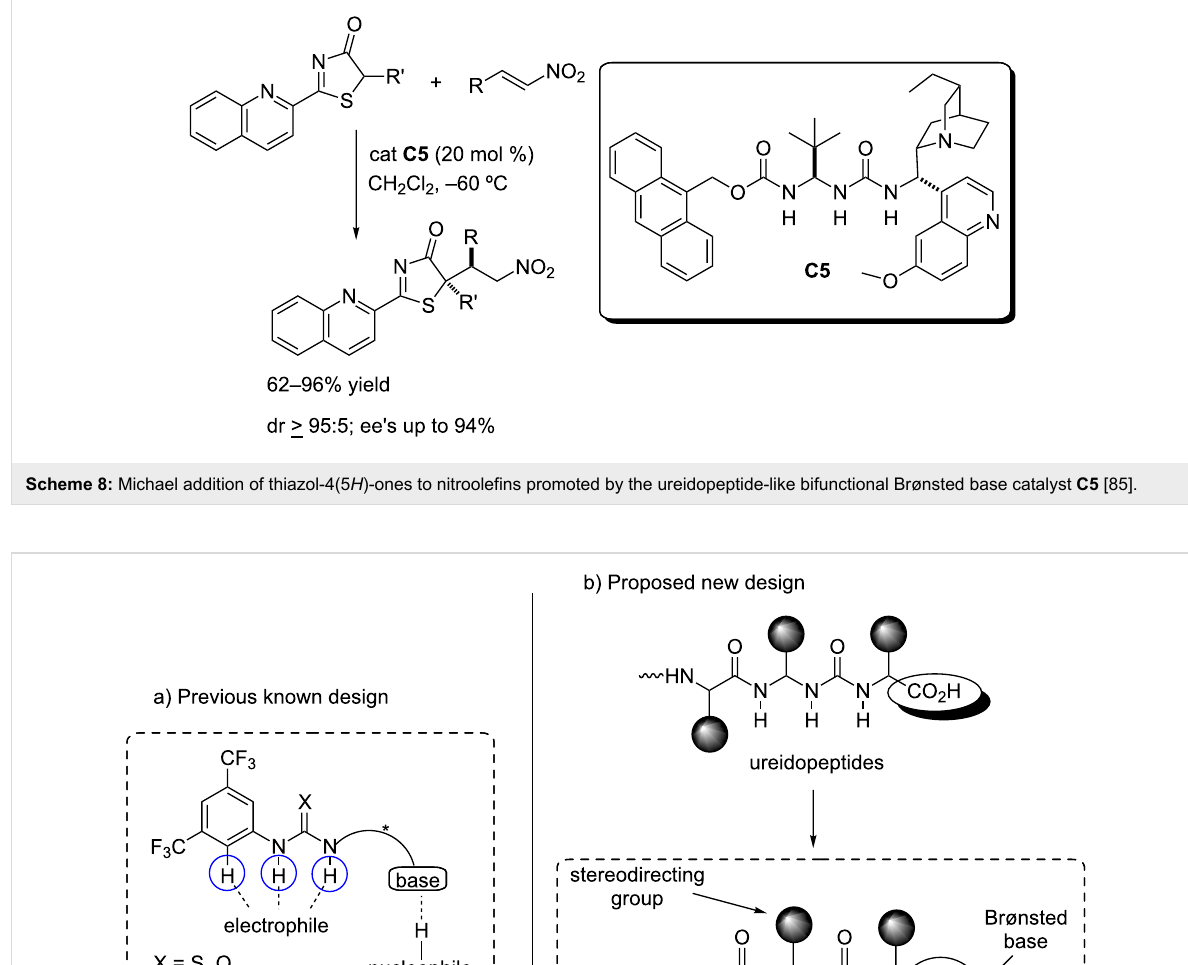
Following this design and starting from the corresponding N -protected α -amino acid 46 different catalysts were easily syn- thesized by the reaction of the respective intermediate isocya- nates 47 [93] with 9- epi -9-amino-9-deoxyquinine or 9- epi -9- amino-9-deoxyhydroquinine (Scheme 9). These catalysts were tested in the reaction between 5-methylthiazolone 49 and nitro- styrene (Scheme 10) and after optimization catalyst C5 was found to be the optimal for this